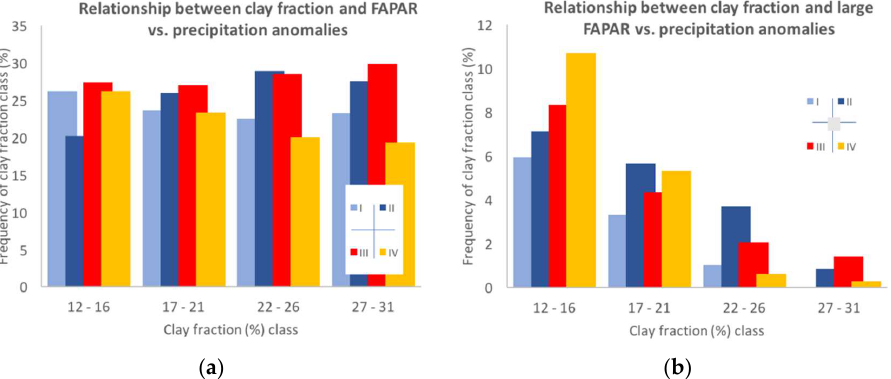
Figure 7. ( a ) Frequency of occurrence of events within each quadrant of Figure 5 grouped by clay fraction class for all events, and ( b ) for events where both FAPAR and precipitation anomalies differ by more than 20% compared to their long-term mean values.